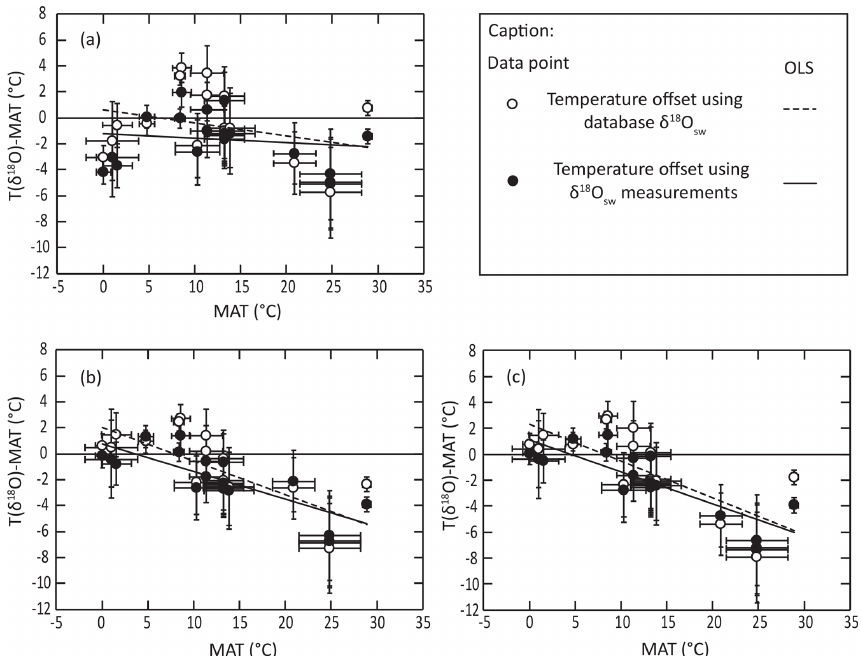
Figure 4. Distribution of isotopic temperature deviation from living temperature against living temperature using the equations of (a) this study, (b) Brand et al. (2013) and (c) Brand et al. (2019) in relation to the dataset of Bajnai et al.